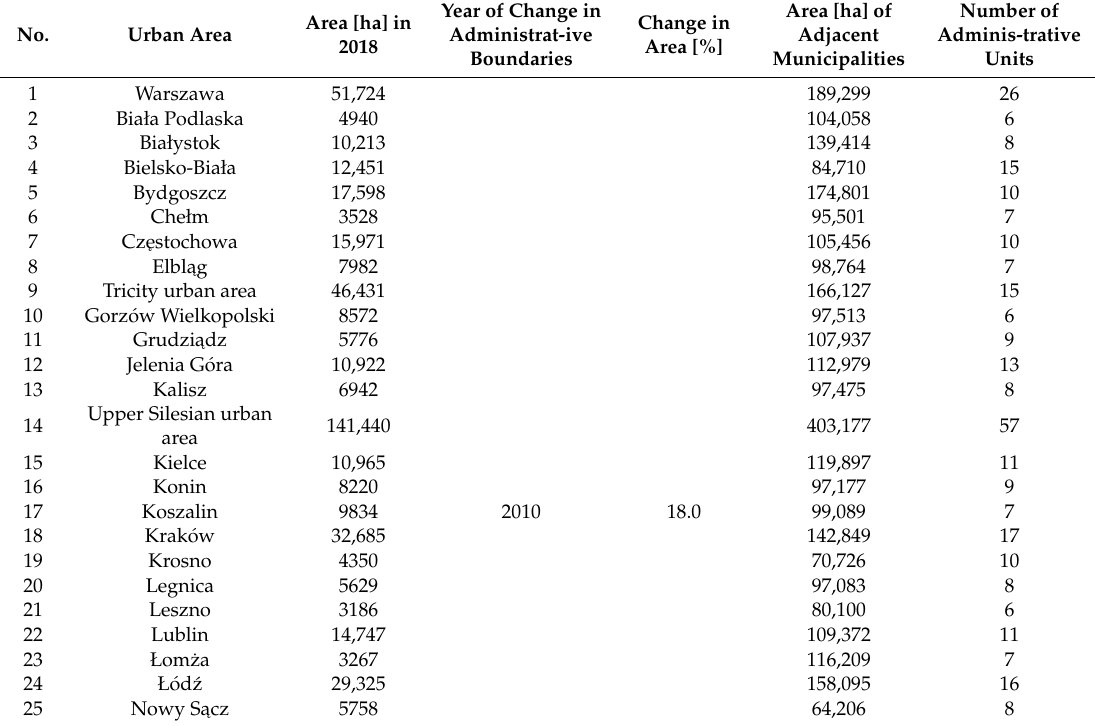
Table A1. The studied urban areas and the surrounding